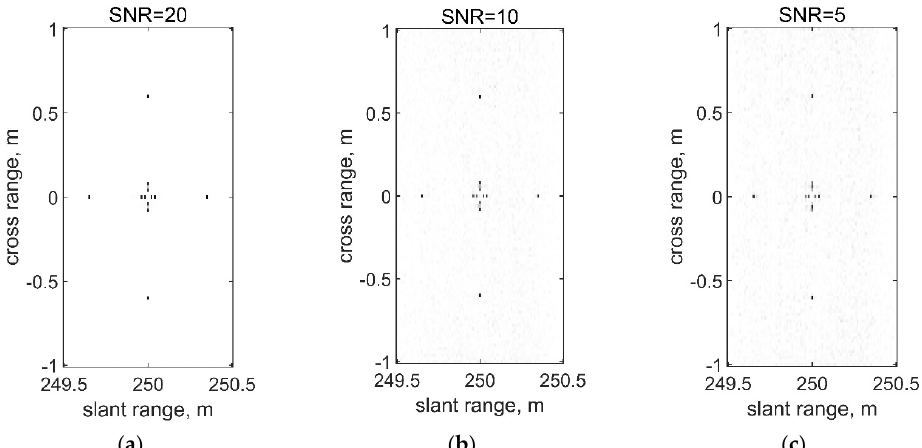
Figure 9. Simulation results of CS-SAS algorithm for Case 5 for single sensor: ( a ) SNR = 20 dB; ( b ) SNR = 10 dB; ( c ) SNR = 5 dB.